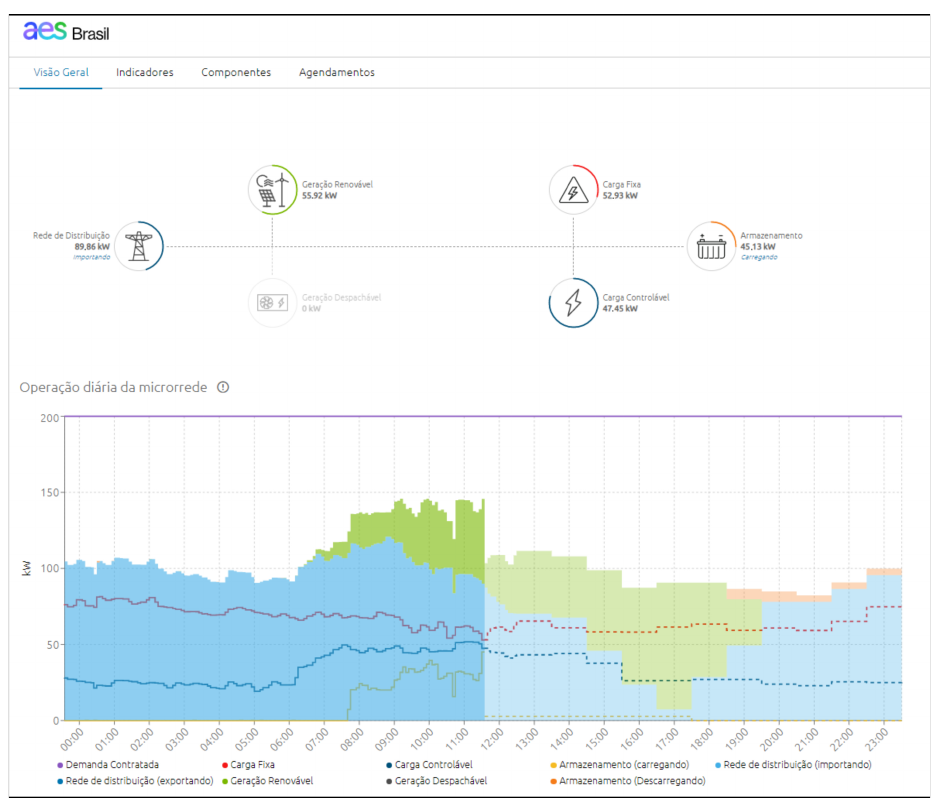
Figure 2. MG platform interface—Overview